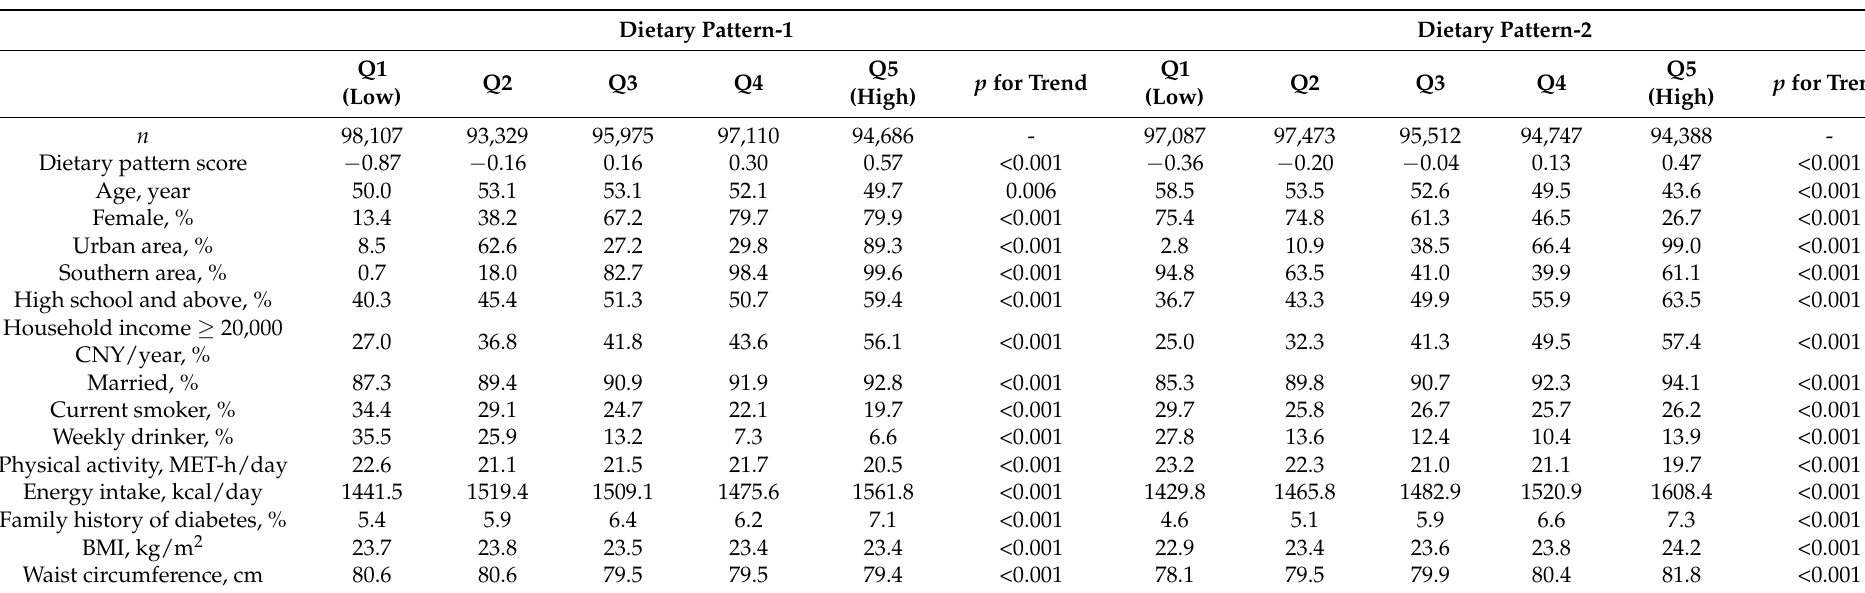
Table 2. Baseline characteristics of participants according to the quintiles of the dietary pattern scores in the China Kadoorie Biobank ( n = 479,207). Dietary Pattern-1 Dietary